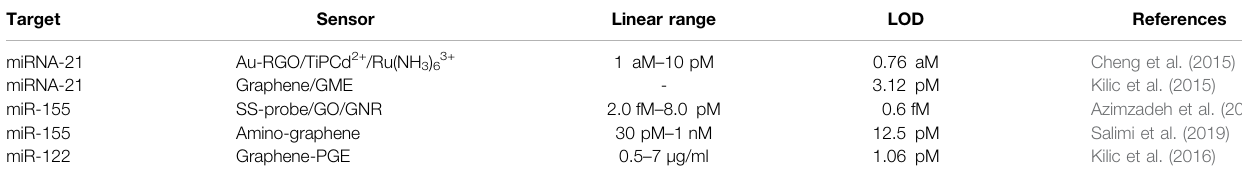
TABLE 2 | Electrochemical sensor for RNA biomarkers in hematological malignancies.